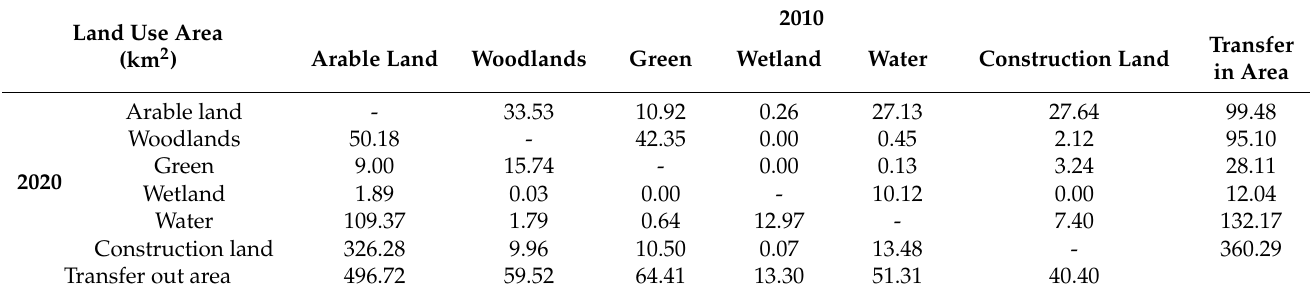
Table 7. Transfer matrix of land use in main districts from 2010 to